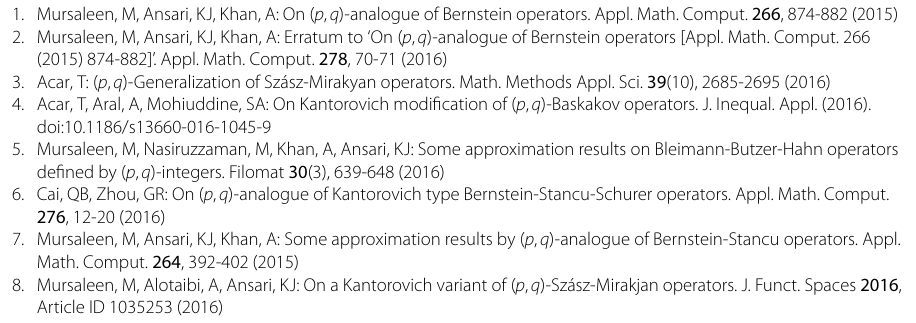
n 1 , q n 1 , p n 2 , q n 2 , p n and n 1 , n 2 1 2 = p n 1